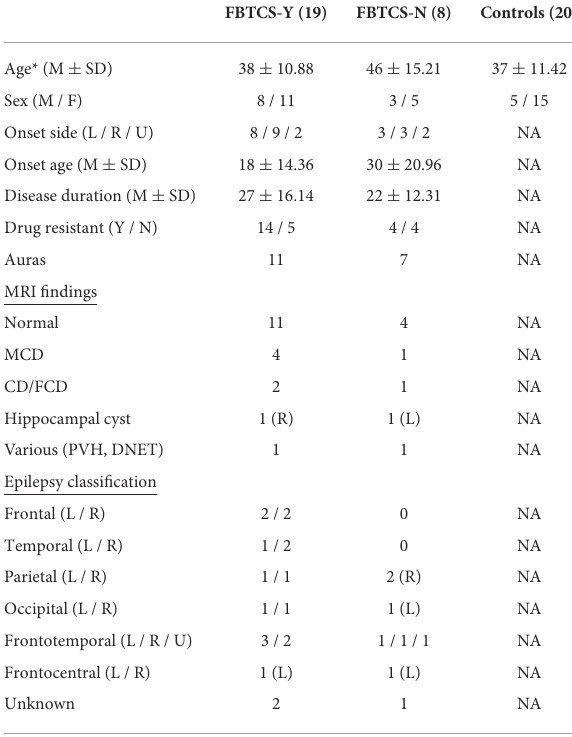
TABLE 1 Participants’ demographic and clinical